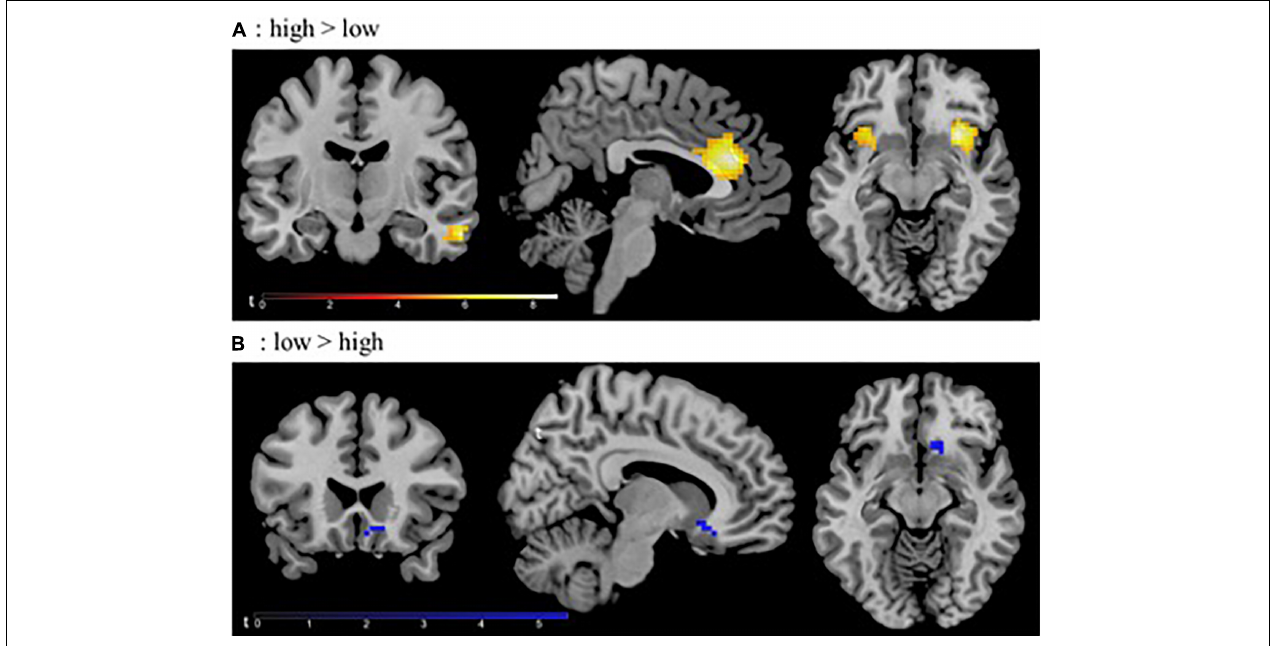
FIGURE 2 | Significant activation clusters of one-sample t -test thresholded at p < 0.05 FEW-corrected for the whole brain; (A) contrast high > low stress condition, (B) contrast low > high stress condition; L, left hemisphere.